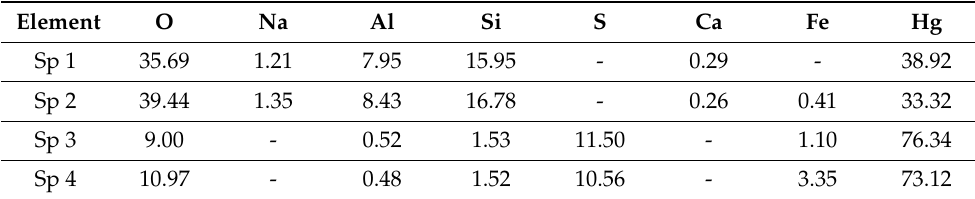
Figure 17. Backscattered electron mode (BSE) image of SZHg ( left ) and the corresponding BSE image with marked four fields (spectra, Sp) for EDS analysis ( right ), both at a magnification of 1000 × . Table 9. Semi-quantitative chemical composition (given in wt %) of the four analyzed fields on the SZHg sample (spectra, Sp; analyzed with EDS).